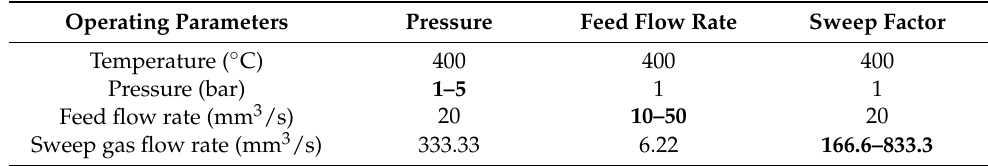
Table 2. The investigated operating conditions for parametric analyses of the MMR and MR perfor- mance during the HI decomposition reaction.